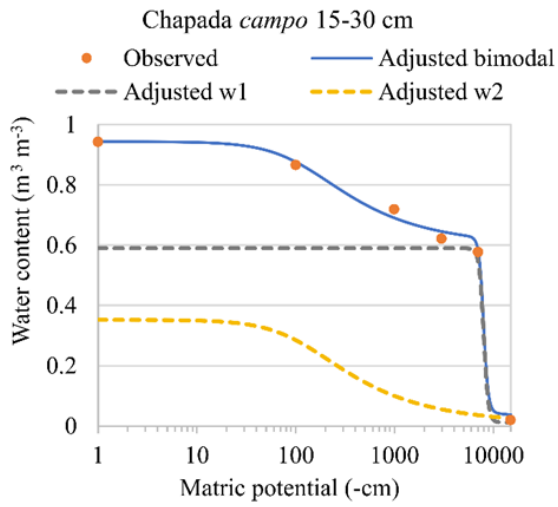
Figure 5. Example of the adjusted bimodal water retention curves based on the van Genuchten model. The bimodal retention curve (blue line) results from the sum of the two others (w1 and